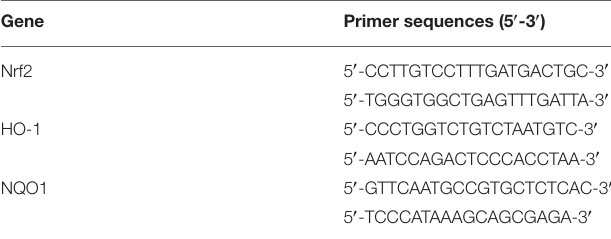
TABLE 2 | Primer sequences of Nrf2, HO-1, and